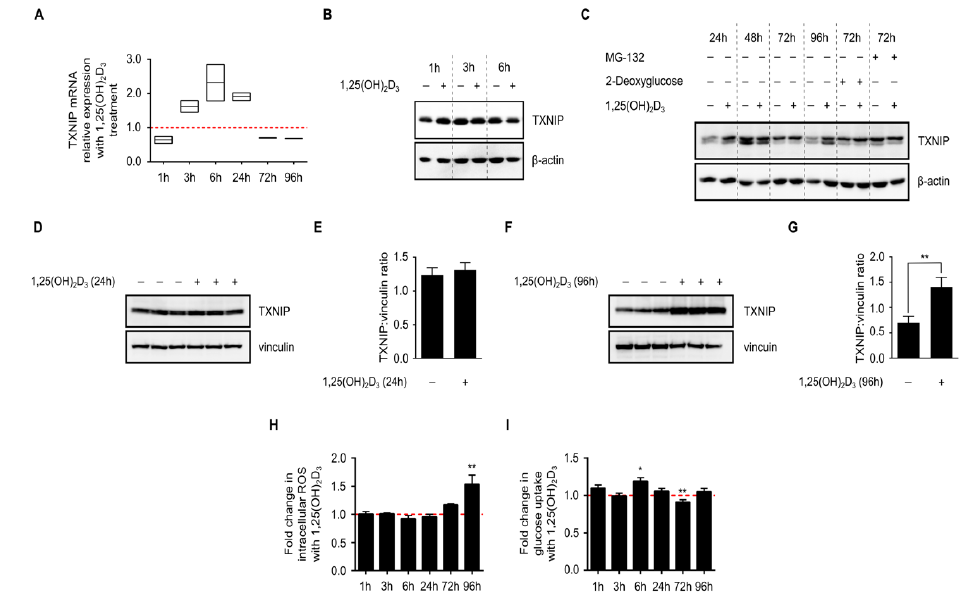
Figure 2. Time-dependent regulation of TXNIP expression and associated cellular processes in HL-60 cells by 1,25(OH) 2 D 3 . ( A ) 1,25(OH) 2 D 3 (100 nM) induced a transient increase in TXNIP mRNA levels that was diminished at later time points. The dashed red line indicates the baseline TXNIP mRNA expression in DMSO-treated cells set to 1; ( B , C ) Immunoblot showing TXNIP protein levels in response to 1,25(OH) 2 D 3 ; induction is observed after 24 h and also after 96 h of treatment. Basal TXNIP levels exhibit temporal fluctuations, independent of treatment. Treatment with 2-deoxyglucose (10 mM), a potent inducer of TXNIP expression, and MG-132 (5 µ M), a proteasomal inhibitor to prevent degradation, were used as positive controls. The compounds were added into the conditioned medium of DMSO- and 1,25(OH) 2 D 3 -treated HL-60 cells either 24 h (2-deoxyglucose) or 6 h (MG-132) before the end of the initial treatment period. “+” and “ − ” denote the presence or absence of the indicated molecule/treatment, respectively; ( D ) Immunoblot and ( E ) densitometric quantification of TXNIP protein levels after 24 h of treatment of HL-60 cells with 1,25(OH) 2 D 3 indicate a mild increase in TXNIP level, which lacks statistical significance; ( F ) Immunoblot and ( G ) densitometric quantification after 96 h of treatment of HL-60 cells with 1,25(OH) 2 D 3 showing a statistically significant induction of TXNIP levels; ( H ) Intracellular ROS levels, presented as fold change of treated vs. control cells, were found to be significantly induced by 1,25(OH) 2 D 3 only at the latest time point (96 h). The dashed red line indicates the baseline ROS level in DMSO-treated cells set to 1; ( I ) Glucose uptake, which is known to be inhibited by TXNIP, was found to be significantly induced by 1,25(OH) 2 D 3 at an early time point (6 h), and reduced at a later one (72 h). Baseline glucose uptake level in DMSO-treated cells is indicated by the dashed red line set to 1. Statistical significance was calculated using a two-tailed Student’s t -test. p -Values less than or equal to 0.05 and 0.01, are depicted by * and **, respectively. Error bars ± SD; n =